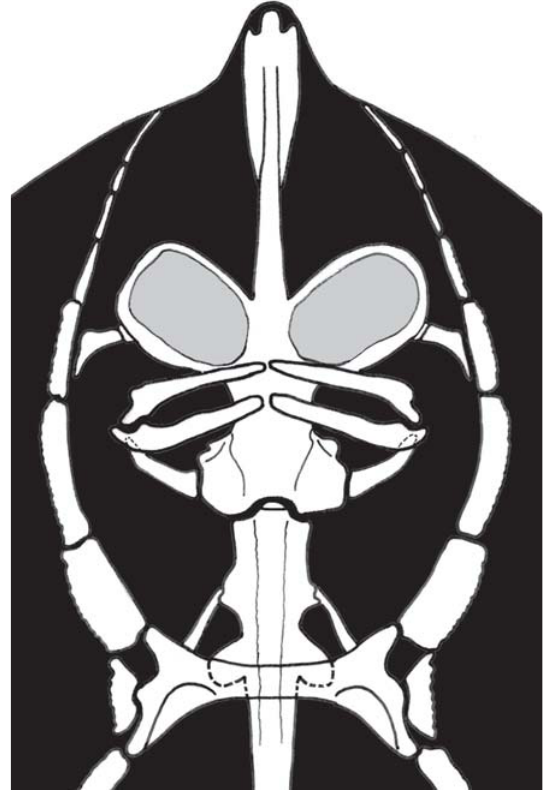
Fig. 10. Schematic depiction of skeletal components anterior to pectoral girdle in Malacoraja obscura , n. sp. (from X-ray radiographs of MNRJ 28290, 505 mm TL). white. Posterior nasal curtain border and integument surround- ing mouth lighter in color (Fig. 5). Larger denticles on anterior snout region and minute denticles on tail yellowish. Horizontaly elongated but irregular whitish blotches present at ventral tail base, extending to pelvic axils in most speci- mens (Fig. 6c; more defined in holotype and small female).